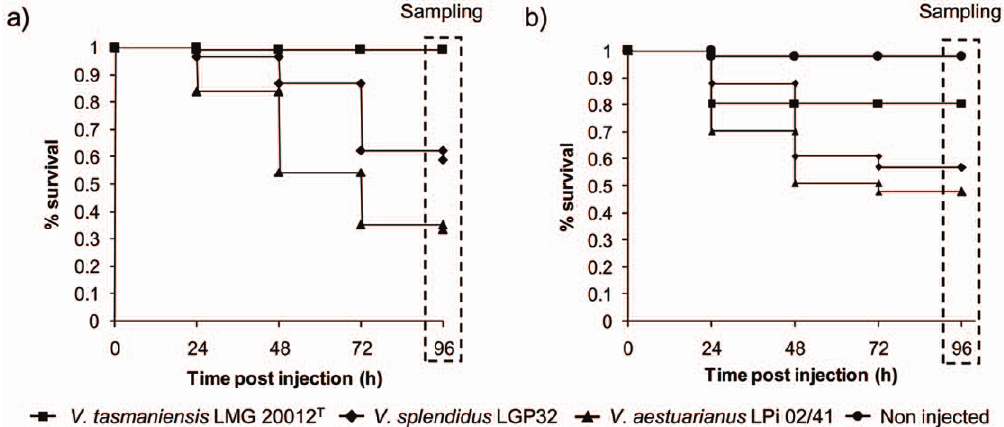
Figure 1. Kaplan-Meier survival curves of C.gigas oysters during infections with virulent Vibrio strains, V.aestuarianus LPi 02/41 or V. splendidus LGP32, and with avirulent V.tasmaniensis LMG 20012 T . Infections for (a) construction of the hemocyte DGE libraries and (b) for gene expression exploration by qPCR analysis, with non injected oysters as control. For the two experiments, hemolymph was individually sampled from oysters that survived the infection at 96 h post-infection corresponding to the end of mortalities.